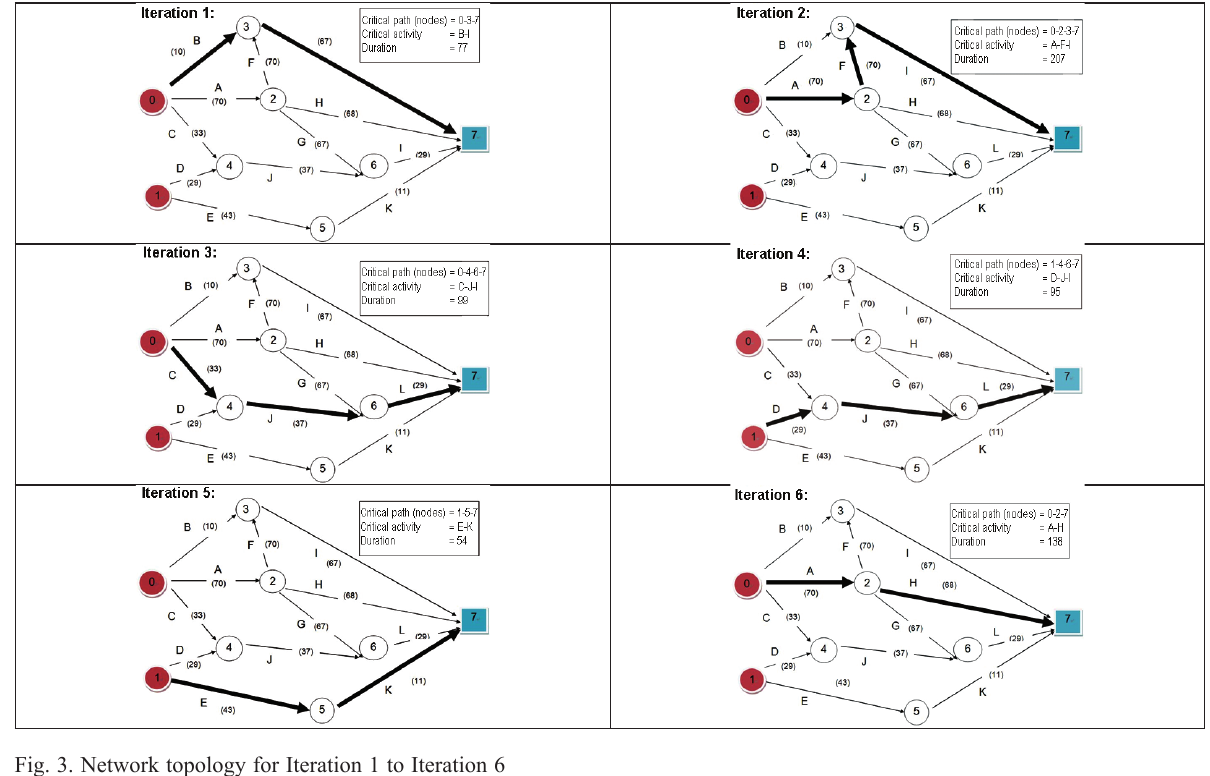
Fig. 3. Network topology for Iteration 1 to Iteration 6 Table 4. Calculation using traditional CPM for trial run Calculation of forward